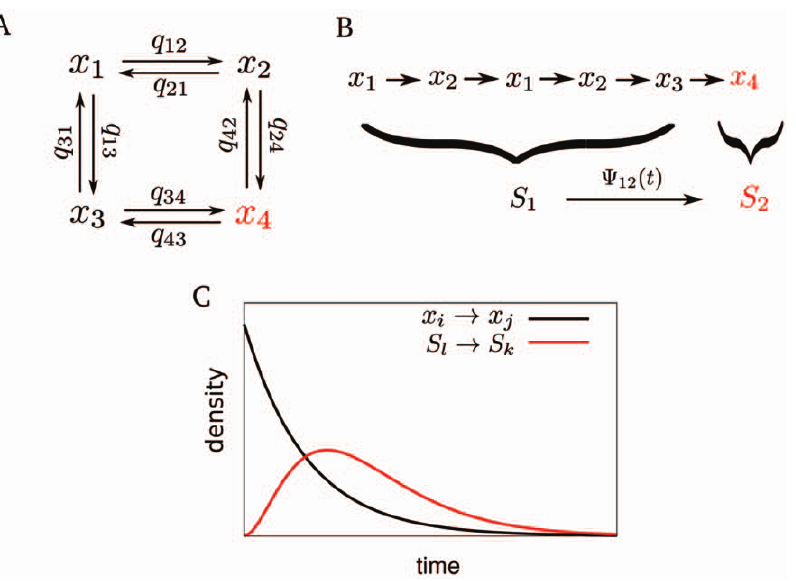
Figure 1. Schematic illustration of hierarchic stochastic modelling. (A) Markovian models consider all possible changes of a molecule x , e.g. binding of regulatory factors, production, degradation. Thus, microscopic state transitions x i ? x j are governed by rate parameters q ij . In the case of IP 3 Rs , the q ij refer to binding (unbinding) of IP 3 and Ca 2 z to (of) their respective binding sites on certain IP 3 R subunits. (B) A typical path of state changes according to (A) includes repetitive switches between individual states before a specific state of interest (here, x 4 ) is reached. The observable states S l are subsets of all microscopic states (here e.g. S 1 ~ f x 1 , x 2 , x 3 g ). In Ca 2 z dynamics, observable states may represent open or closed clusters of IP 3 Rs . (C) Microscopic transitions x i ? x j with parameters q ij induce exponential waiting time probabilities q ij exp( { P transitions S l ? S k follow waiting time probabilities Y lk ( t ) , which can have one or several maxima due to their internal dynamics.